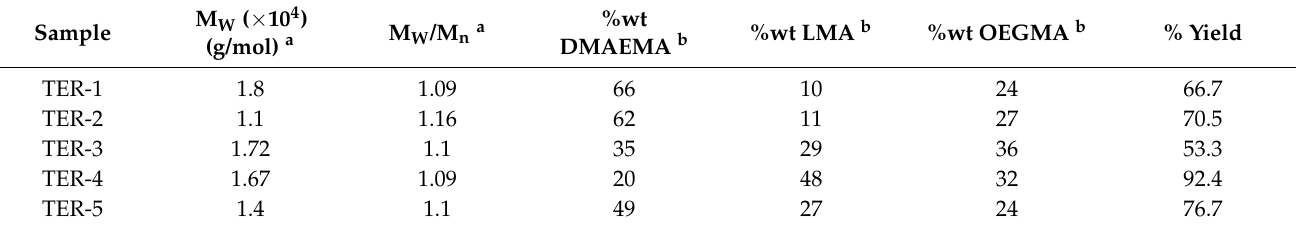
Table 1. Molecular characteristics of the five P(DMAEMA-co-LMA-co-OEGMA) terpolymers.